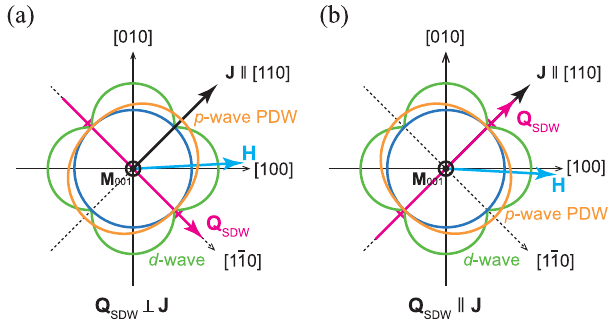
FIG. 4. Schematics of the d -wave (green) and the p -wave PDW (orange, described by the vector d 1 ) superconducting order parameters, the Q vectors and the corresponding SDW gaps (magenta arrow and arcs, respectively), and the mag- netic-field directions (cyan arrow). A combination of a SDW [28] and a p -wave PDW [14,27] d 1 component is consistent with ⊥ J , the p -wave the thermal conductivity data. (a) When Q SDW antinodes gap the nodes of the d wave along J (black arrow), sharply reducing the thermal conductivity. (b) The effect of the SDW gapping the nodes along J must be smaller (by a factor of approximately 2) than the similar effect of the p -wave PDW state in